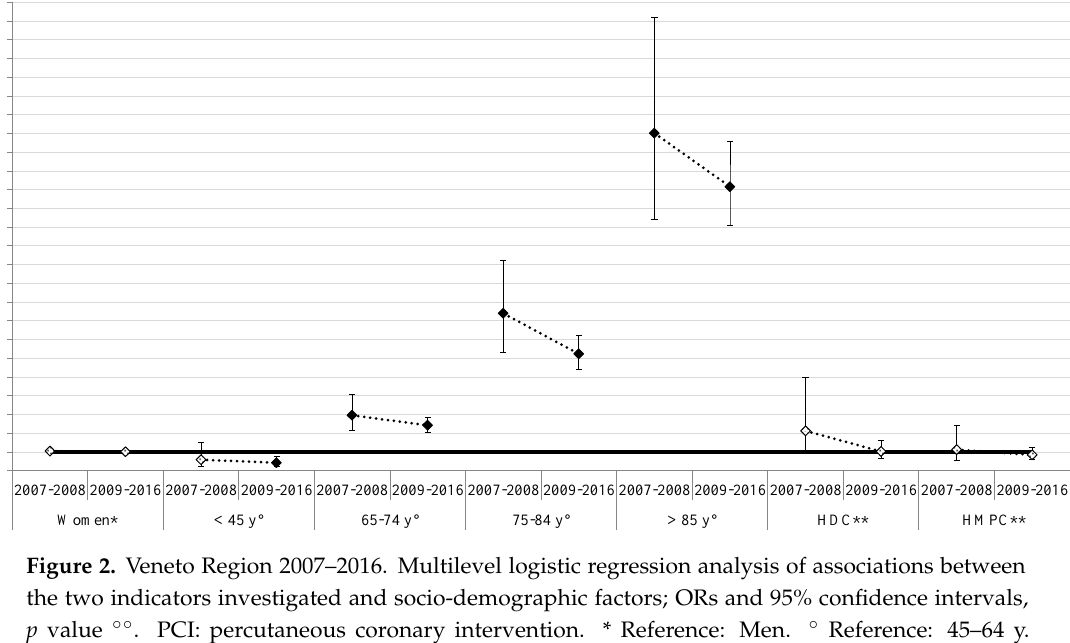
Figure 2. Veneto Region 2007–2016. Multilevel logistic regression analysis of associations between the two indicators investigated and socio-demographic factors; ORs and 95% confidence intervals, p value ◦◦ . PCI: percutaneous coronary intervention. * Reference: Men. ◦ Reference: 45–64 y. ** Reference: Italian. ◦◦ full indicator → p < 0.05.